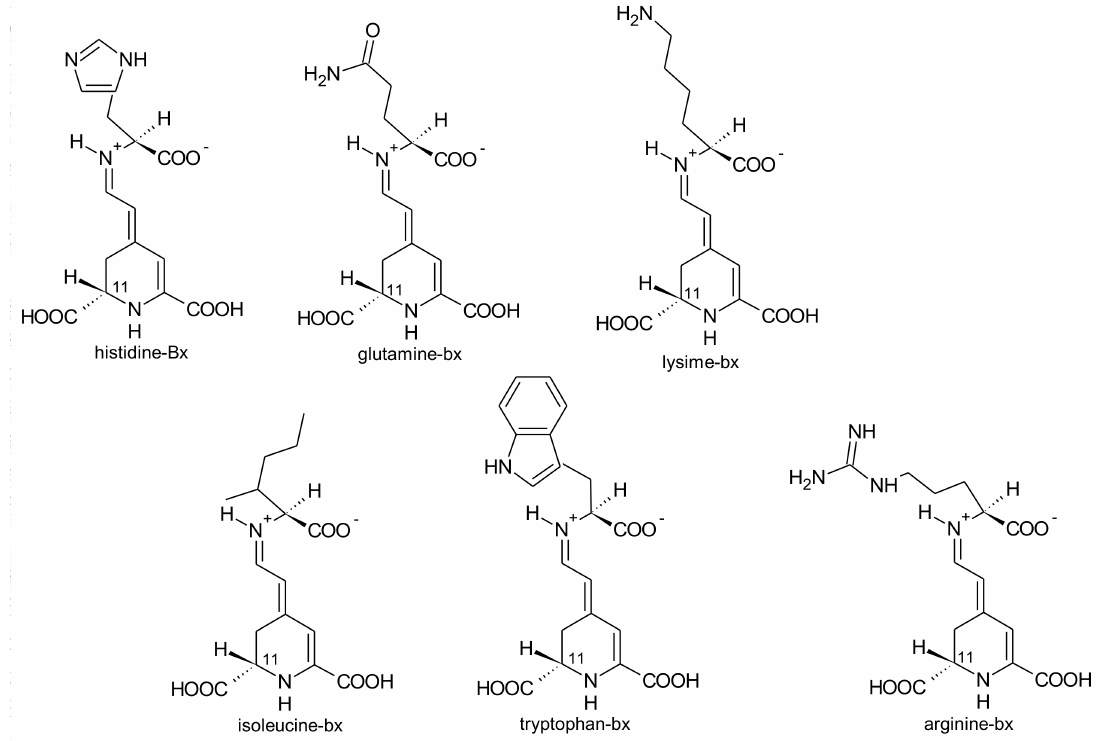
Figure 5. Betaxanthins found in red inflorescences of G. globosa